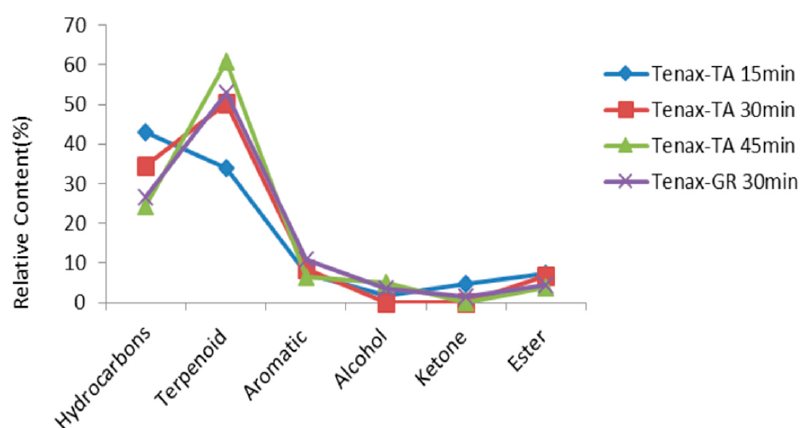
Figure 1. Percentage of alcohols, hydrocarbons, and other compounds released from Dendranthema morifolium (Ramat.) Yellow (No. 1 ) in dependence of sampling times and absorbents.